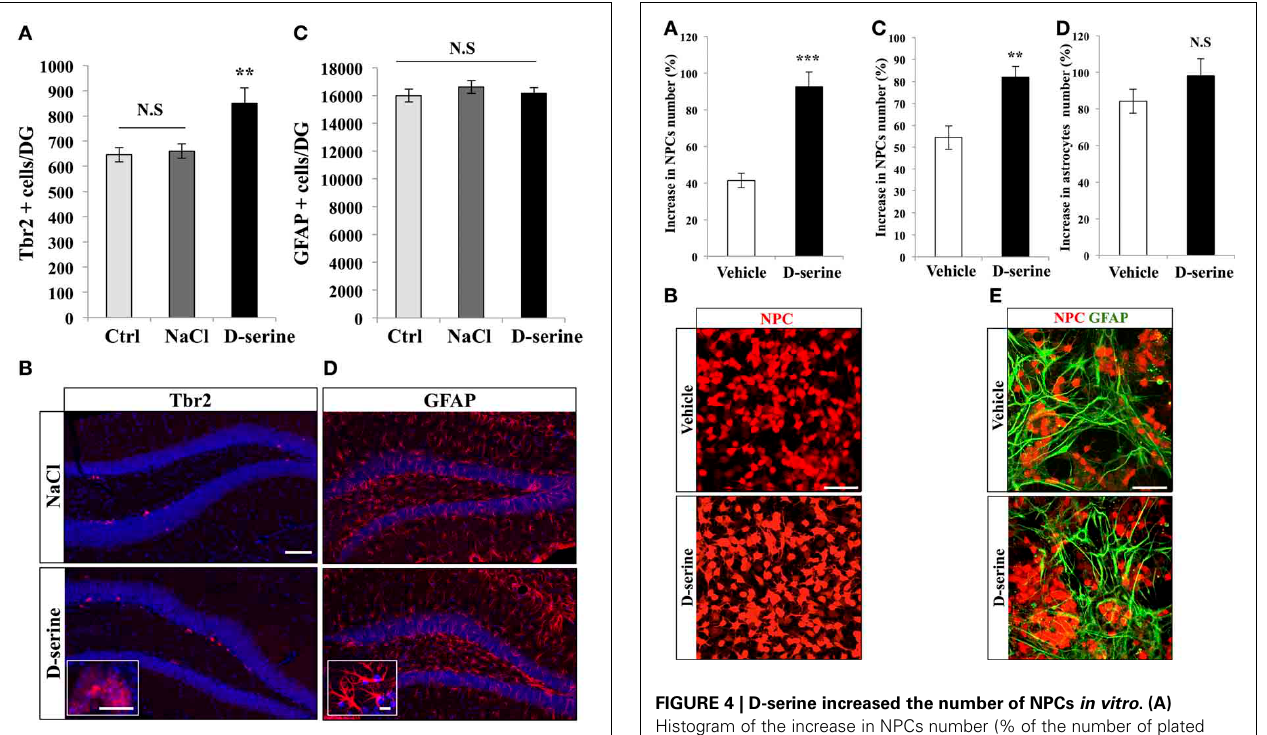
FIGURE 3 | D-serine increased the number of Tbr-2-expressing cells. (A) Histogram showing the number of Tbr2-expressing cells in the granule cell layer of the dentate gyrus of mice injected with D-serine or NaCl and in control, non-injected animals (Ctrl). Animals: n = 4 animals per group. (B) Confocal maximal projection micrographs of hippocampal sections immunostained for Tbr2 from the two injected groups. Inset: higher magnification micrograph of Tbr-2-immunolabeled cells. (C) Histogram showing the number of GFAP-expressing cells per dentate gyrus of injected mice (D-serine and NaCl) and in control, non-injected animals (Ctrl). Animals: n = 4 per groups. (D) Confocal maximal projection micrographs of hippocampal sections immunostained for GFAP from the two experimental groups. Inset: higher magnification micrograph of a GFAP-immunostained cell. Blue: Dapi staining. Each value represents the mean ± SEM; post-hoc bilateral Student’s t -test, ( ∗∗ p < 0 . 01), N.S., Non-significant ( p > 0 . 05). Scale bar: 100 μ m, insets 10 μ m.